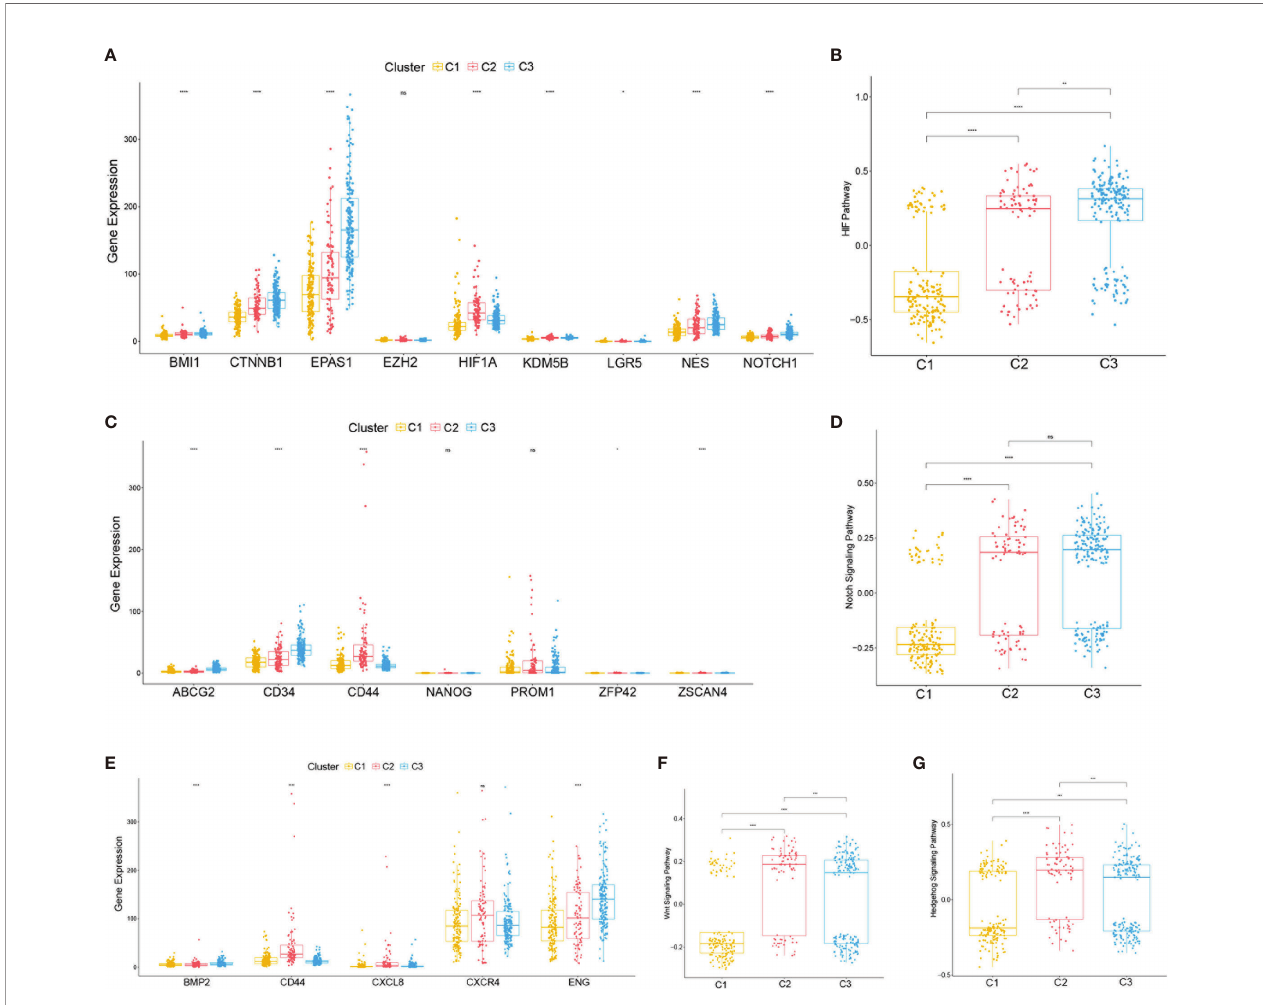
FIGURE 4 | Expressions of clear cell renal cell carcinoma (ccRCC) stem cell-related genes and pathways. (A, C, E) Expression levels of cancer stem cell marker genes (A) , normal stem cell marker genes (C) , and ccRCC cancer stem cell marker genes (E) . (B, D, F, G) Box plot of the status of ccRCC cancer stem cell-related pathways. The p -values are labeled above each box plot with asterisks . ns , no signi fi cance. * p < 0.05, ** p < 0.01, *** p < 0.001, **** p <